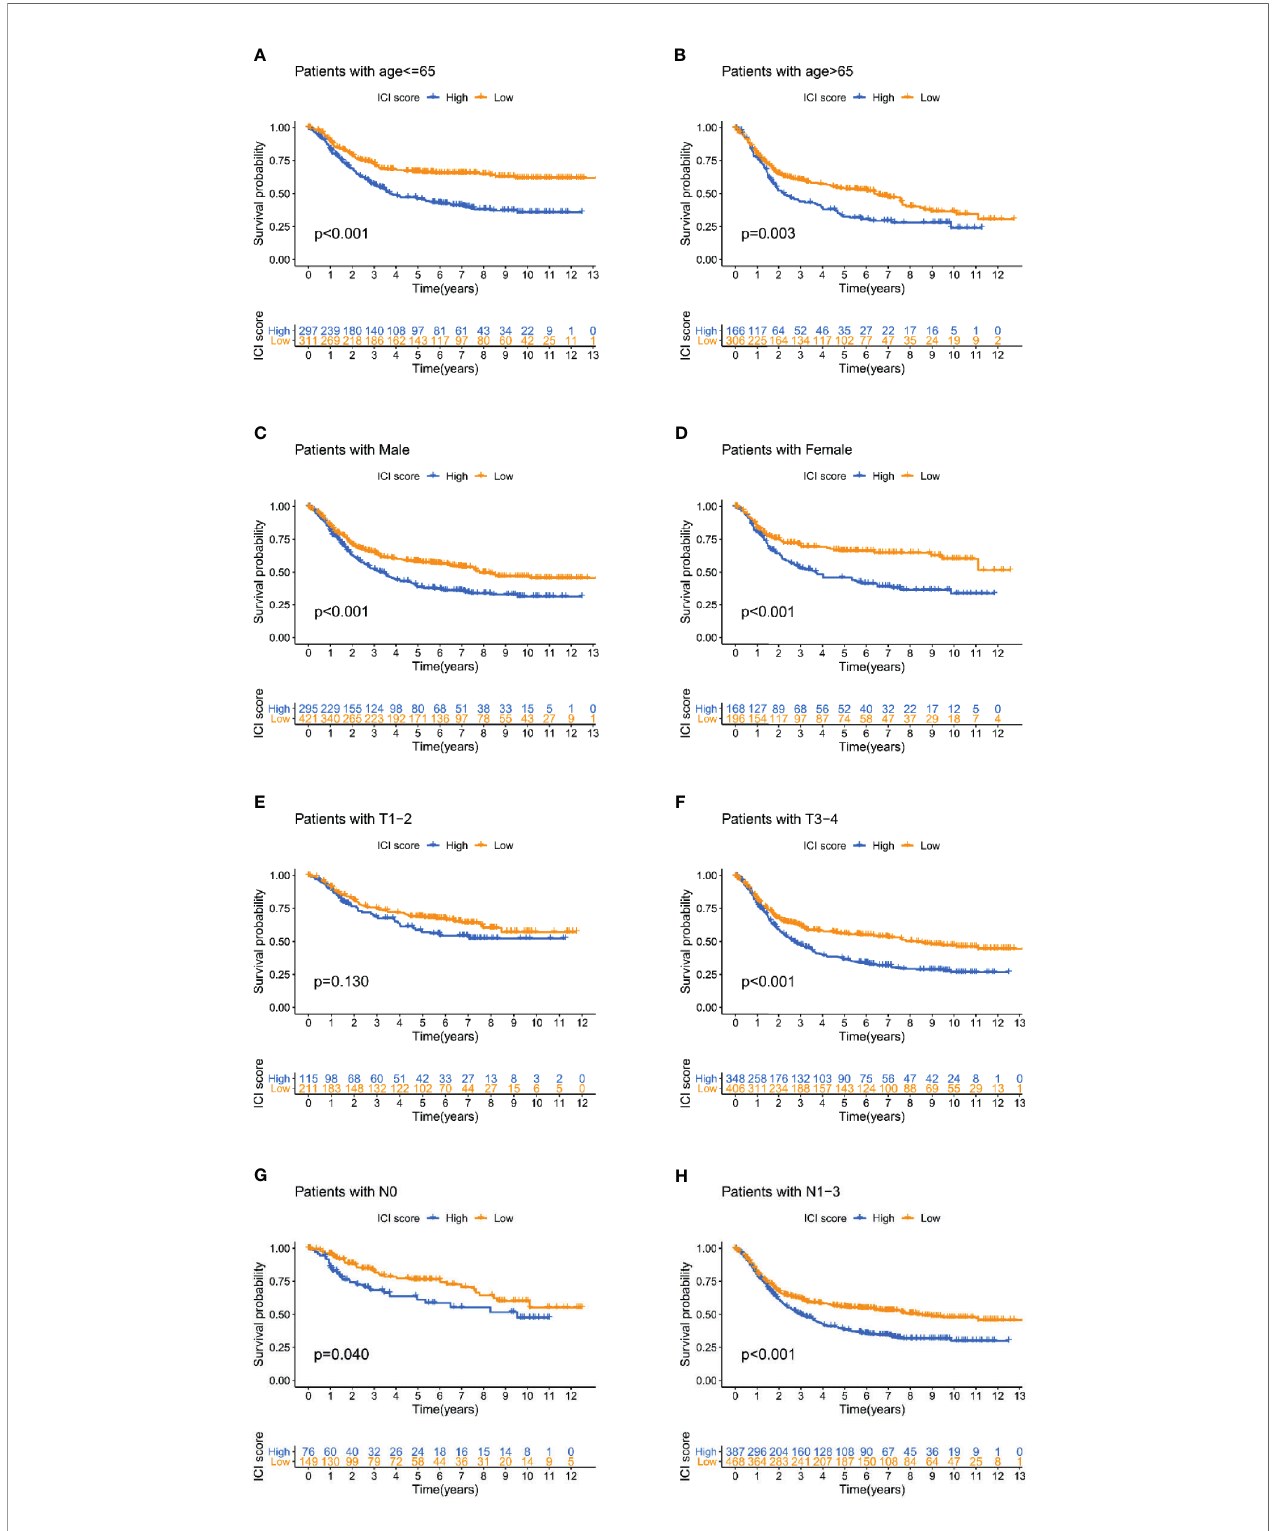
FIGURE 4 | The prognosis-predicting ef fi cacy of the ICI score classi fi cation system in different clinical subgroups. (A – D) Lower ICI score could help predict the better overall survival regardless of the age and gender. (E – H) The predictive ef fi cacy was weakened in early-stage cases compared with the advanced stage